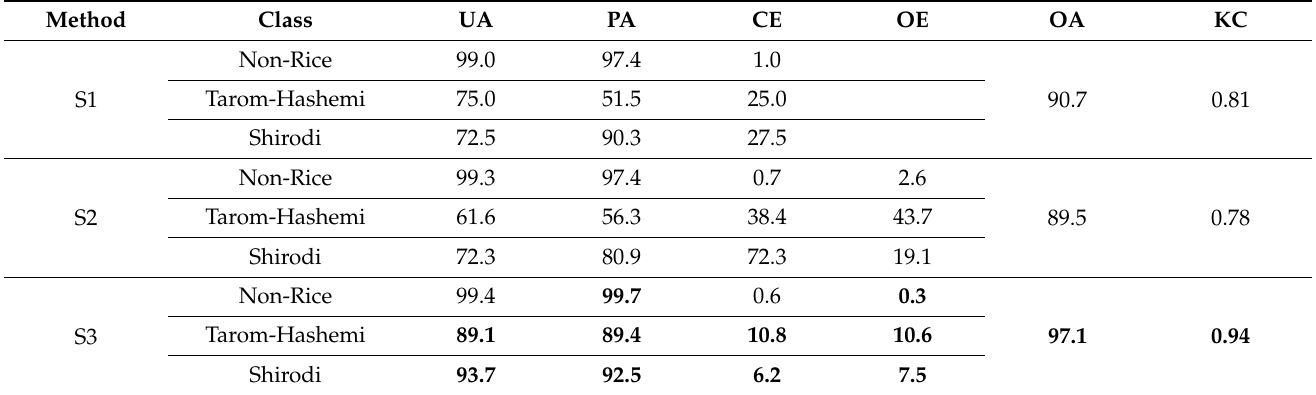
Table 6. Comparison time-series Sentinel-1 and Sentinel-2 based NDVI datasets in rice variety mapping. The bold values show the highest